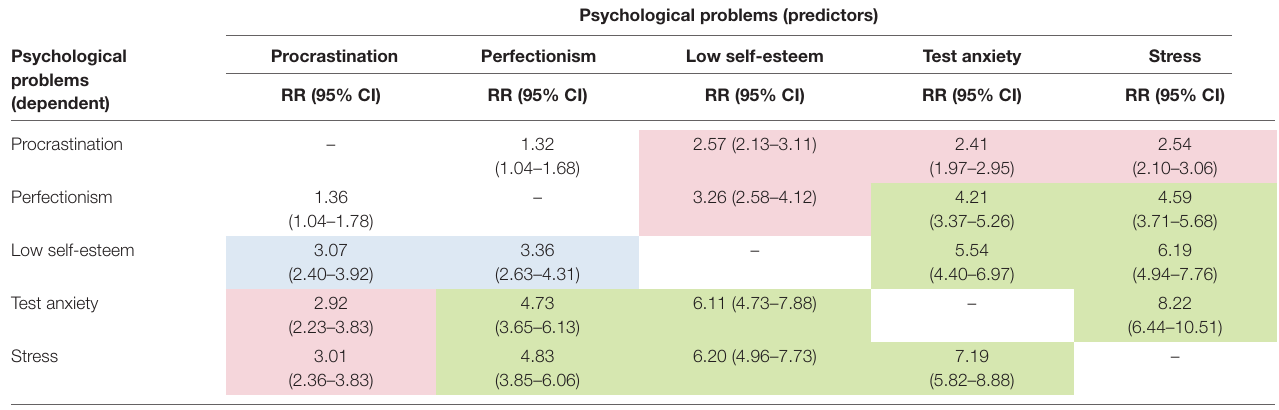
TABLE 2 | Associations (relative risks; RR and their 95% confidence intervals; 95% CIs) between common psychological problems: bivariate Poisson regressions in a weighted sample of Dutch university students ( n =